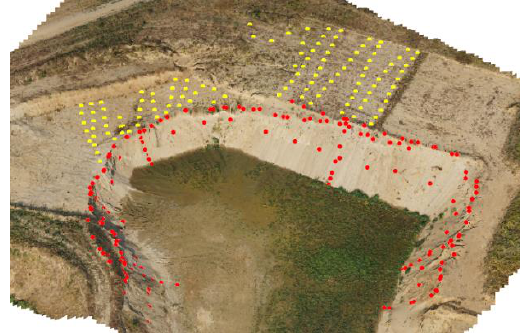
Figure 17. 3D distances between CKP2 set and the scenario 2 Scenario 2, based on different imagery and different geometry, clearly has another behaviour, see Figure 17.